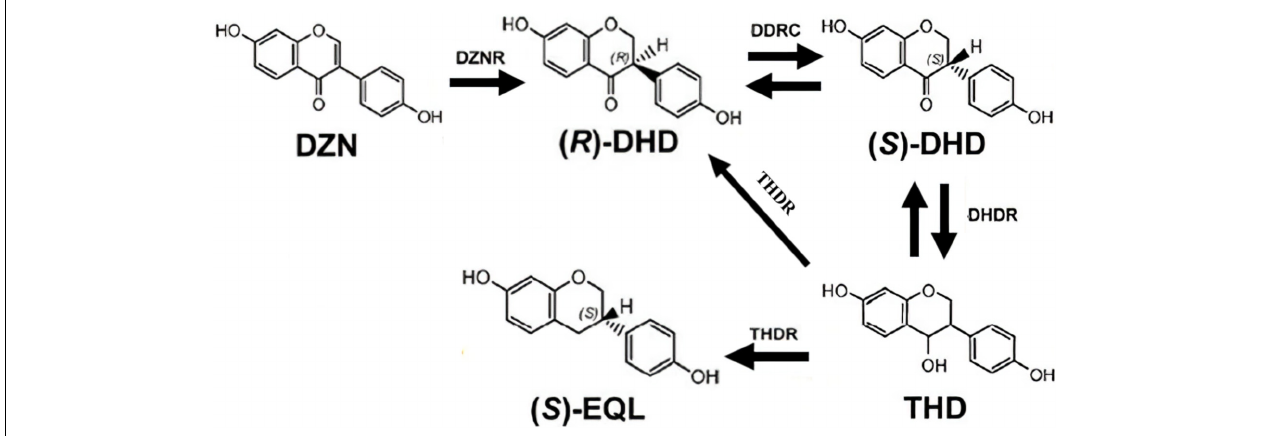
FIGURE 1 | Model of the ( S )-EQ biosynthetic pathway. It has been reported that at least four genes were involved in producing ( S )-EQ, including daidzein reductase (DZNR), dihydrodaidzein racemase (DDRC), dihydrodaidzein reductase (DHDR), and tetrahydrodaidzein racemase (THDR). ( S )-EQ production requires that daidzein is first metabolized into dihydrodaidzein by DZNR and DDRC, and further metabolized into tetrahydrodaidzein and then into ( S )-EQ by DHDR and THDR.